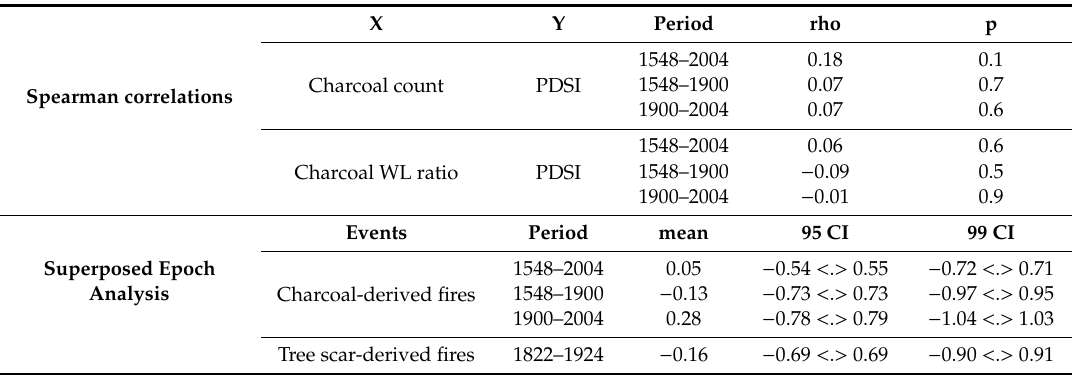
Table 1. Correlations between fire event years and moisture conditions at Cedar Creek. Spearman rank sum test correlations between charcoal count and WL ratio and PDSI values from the analyzed NADA gridpoint. Superposed Epoch Analysis (SEA) of PDSI values 10 year prior and after fire events reconstructed from charcoal peaks or tree scars. Three periods have been considered: (1) the entire charcoal or tree scars time extend, (2) pre-settlement period as defined by the period before 1900 AD, and (3) post-settlement period as defined by the period after 1900